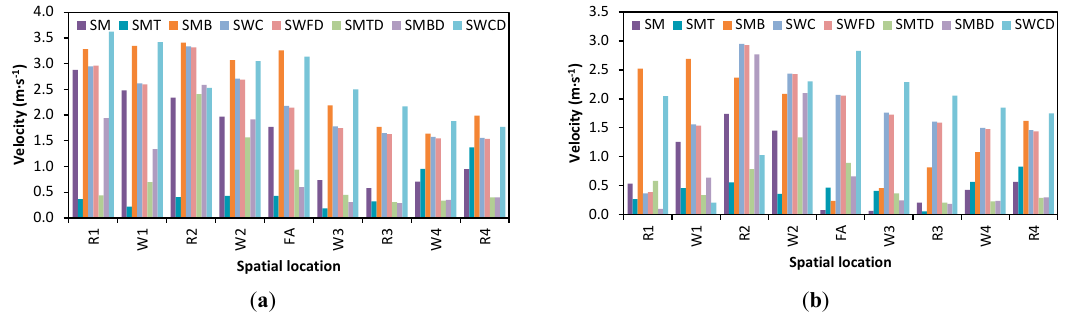
Figure 11. Effects of different opening combinations on air velocities in different locations away from the windward side at the middle of the barn ( a ) at the cow height and ( b ) close to the emission surface. R—Cow resting area, W—Cow walking area and FA—Feeding alley.